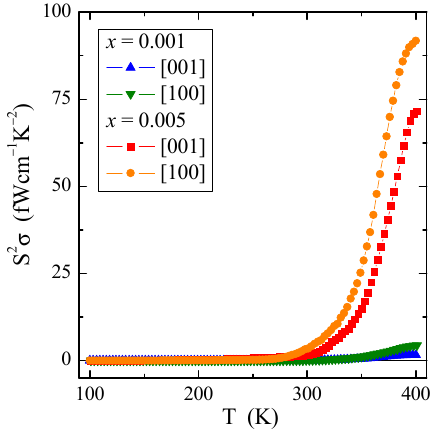
Figure 8. Power factor S 2 σ vs. temperature T of PNMWO single crystals.